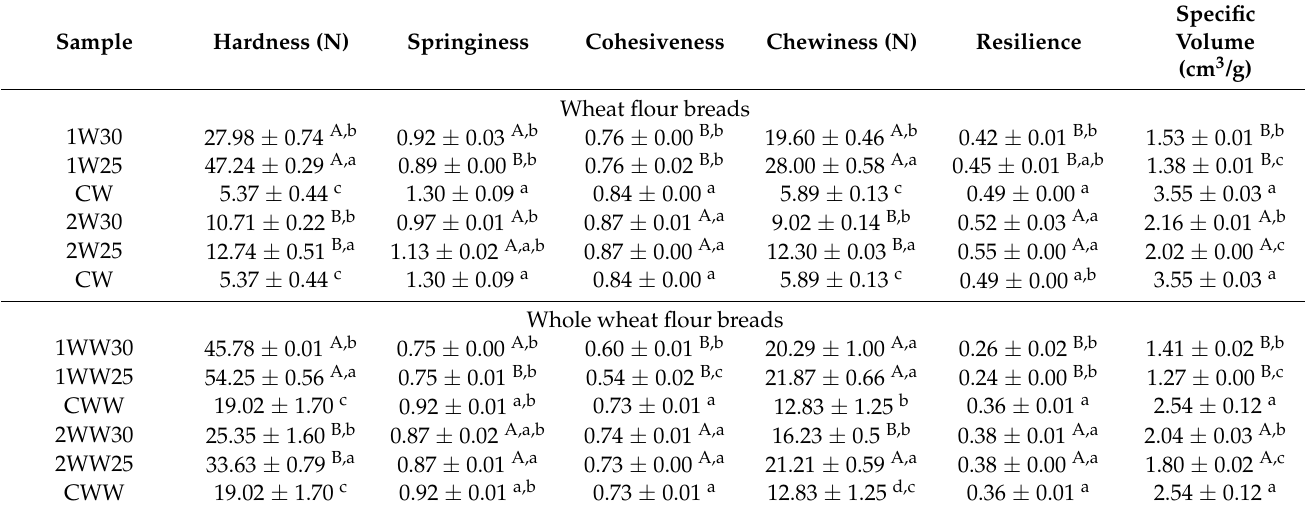
Table 3. Physical properties of sourdough and control bread